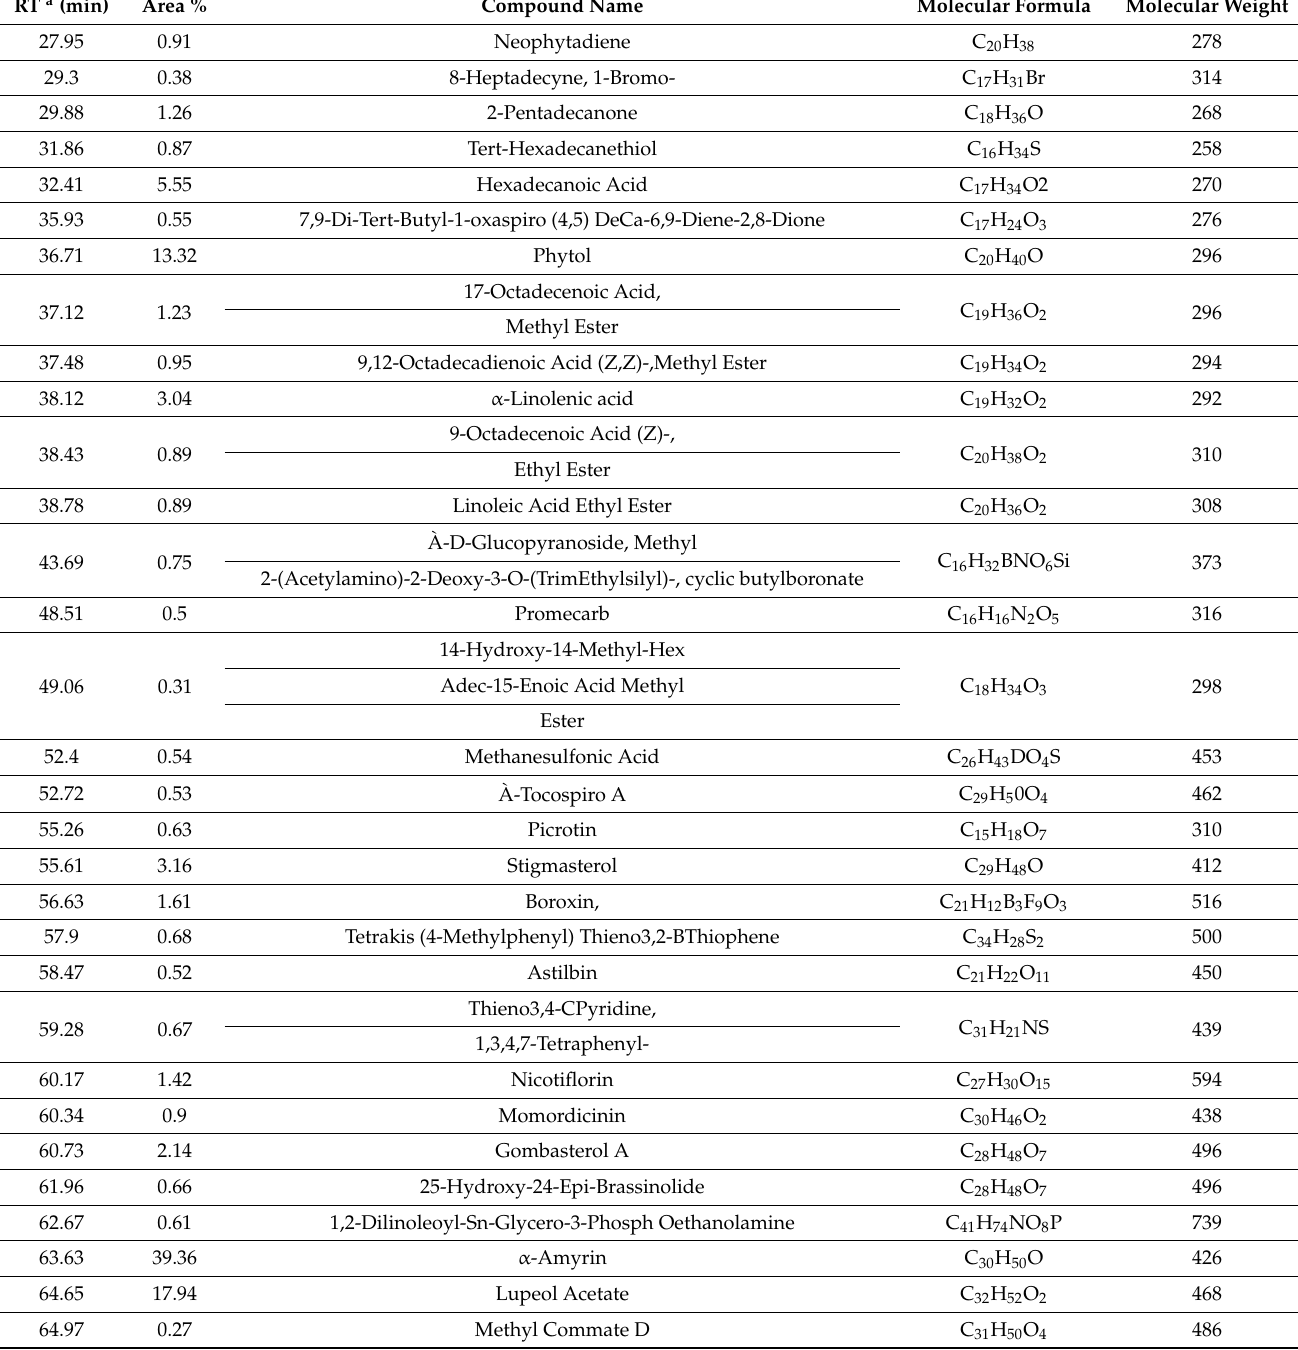
Table 2. Identification of phytocomponents of ethanolic extract of C. procera leaves using GC– MS